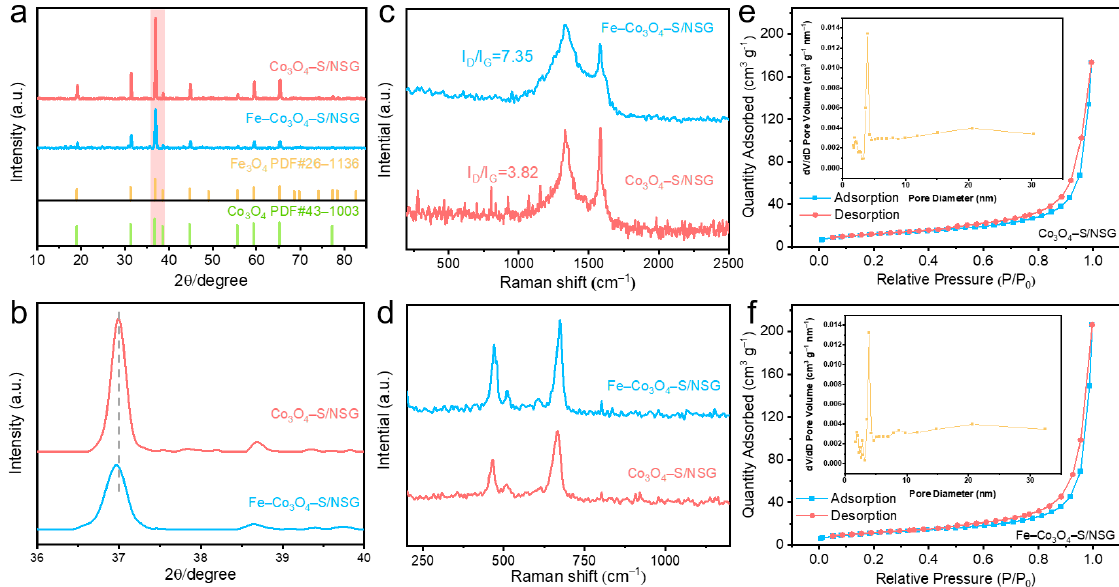
Figure 2. ( a ) XRD patterns of Co 3 O 4 –S/NSG and Fe–Co 3 O 4 –S/NSG along with the JCPDS card of Fe 3 O 4 and Co 3 O 4 and ( b ) enlargement of the (311) peak region. ( c , d ) Raman spectra and ( e , f ) N 2 adsorption–desorption isotherms (inset: pore size distribution) of Fe–Co 3 O 4 –S/NSG and Co 3 O 4 –S/NSG.